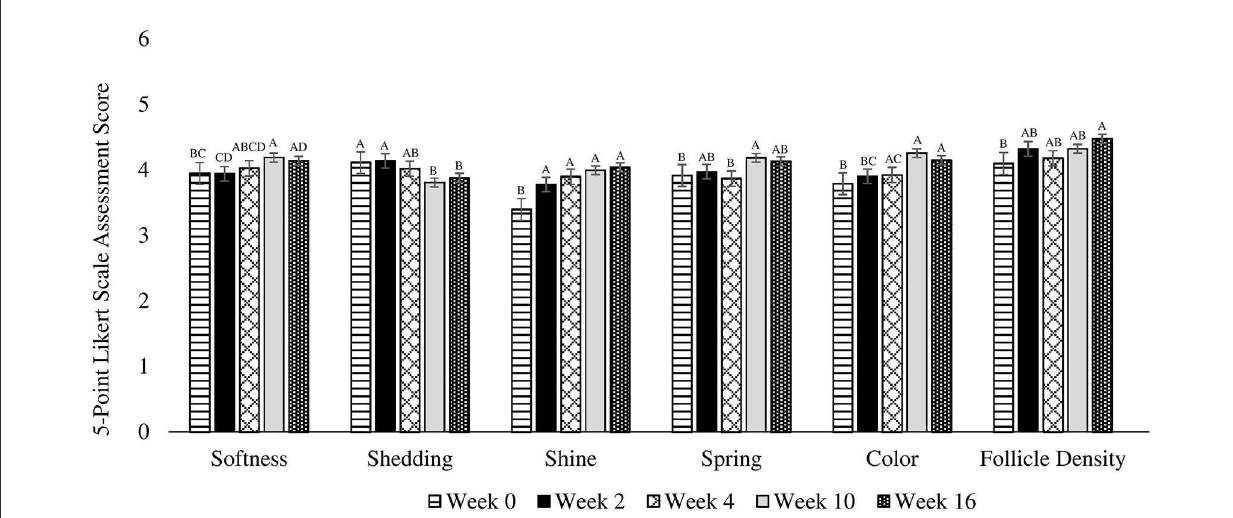
(Figure 1). Additionally, softness was greater in females compared to males ( P =